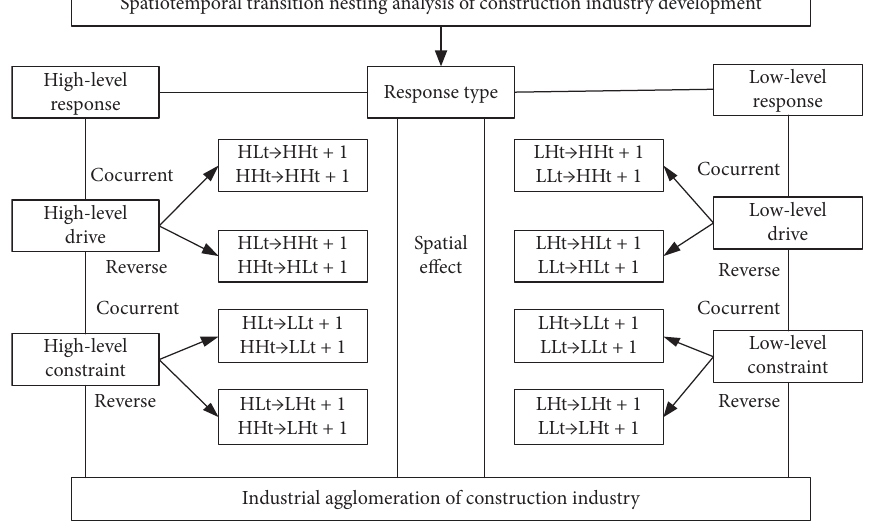
Figure 1: The mechanism of spatial and temporal transition and nested analysis of construction industry